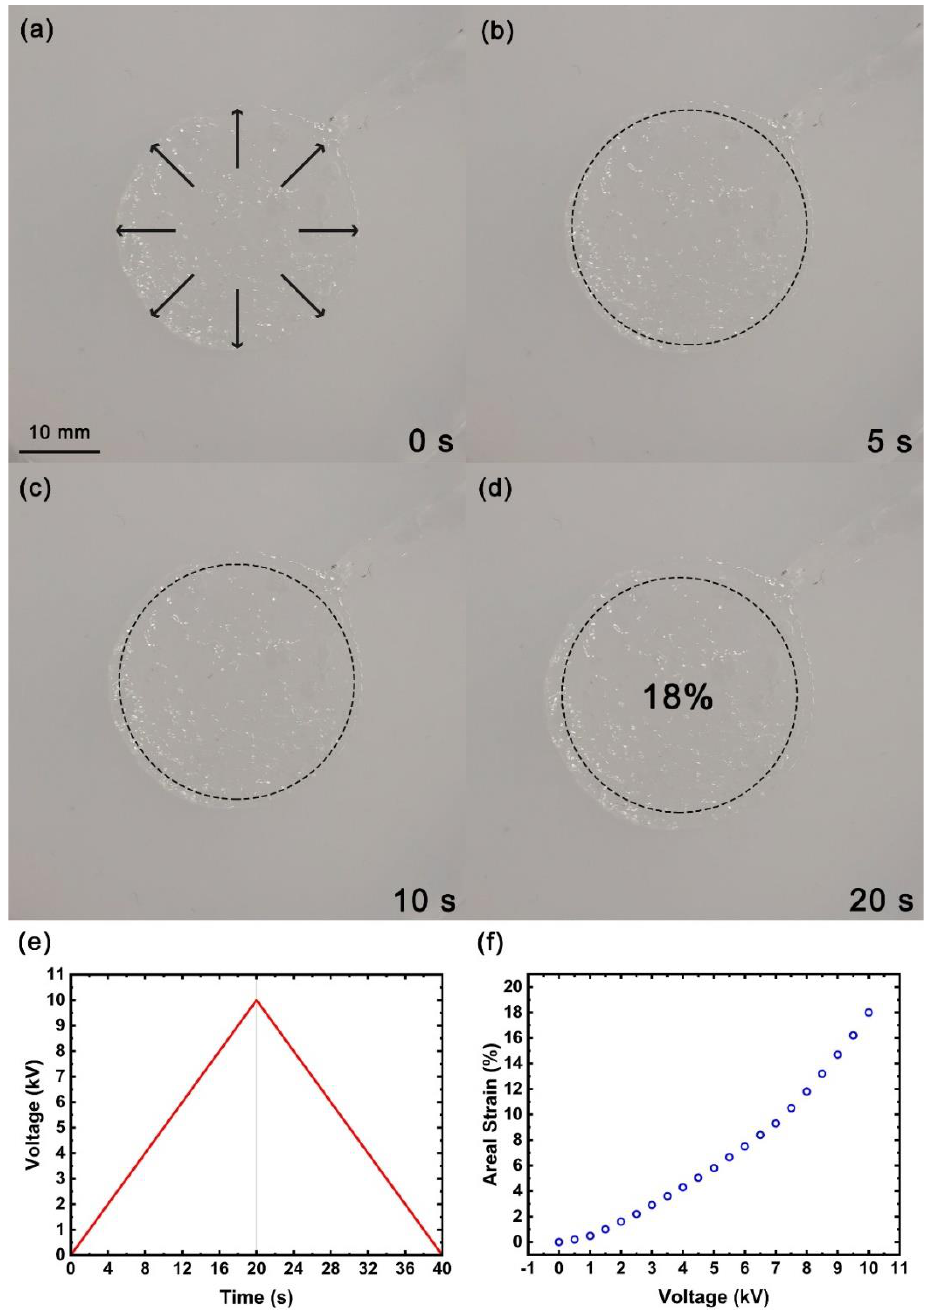
Figure 8. Flexible actuator based on PAM conductive hydrogel electrodes. ( a – d ) When an external voltage of triangular waveform with a period of 40 s is applied, the area of the flexible actuator expands over time; ( e ) triangular waveform external voltage with a period of 40 s; ( f ) the area strain measured at 20 s after the voltage was applied.